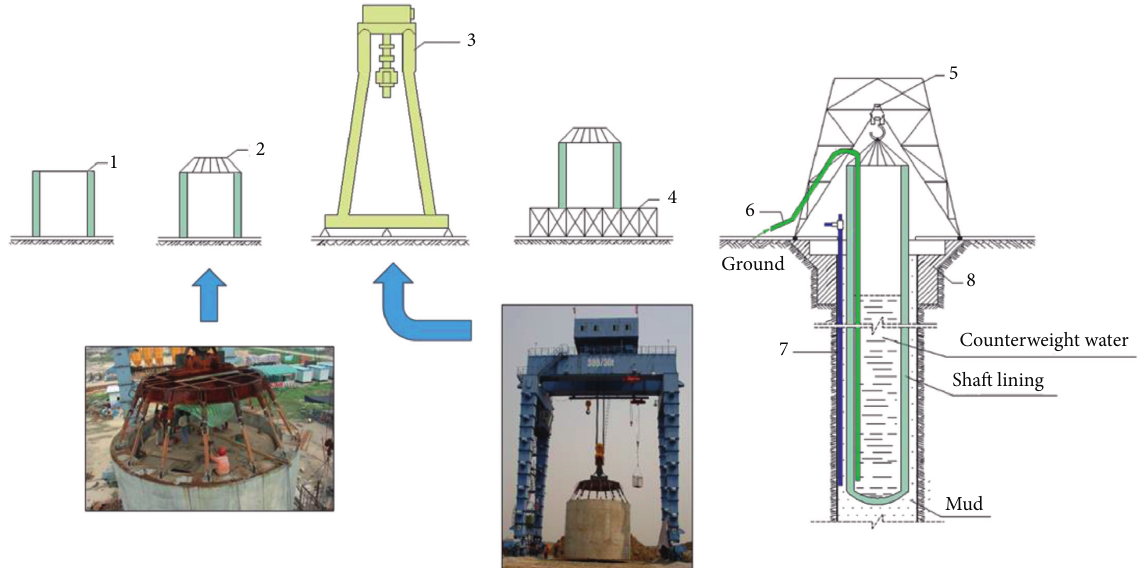
Figure 1: Schematic representation and the scene diagram of suspension and subsidence in drilling shaft sinking: (1) shaft segment; (2) hanging cap; (3) gantry crane; (4) drilling platform; (5) hook; (6) main water pipe; (7) pumping pipe; (8) guided